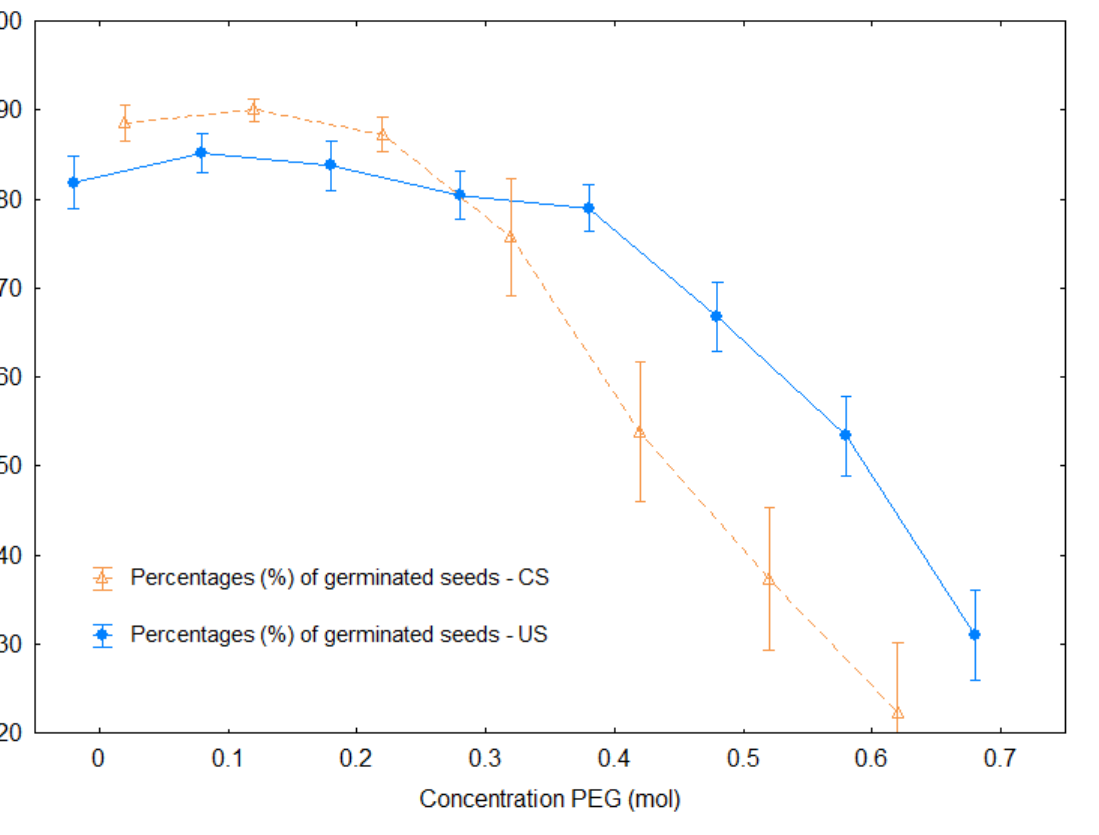
Figure A1. Mean values of seed germination capacity in the US and CS treatments at different PEG concentrations. Average values are shown for all indicator plants for the US (n = 20 ± SE) and CS (n = 20 ± SE) variants at the respective PEG concentrations of 0.0–0.7 mol. US = Uncoated Seeds, CS = Coated Seeds.